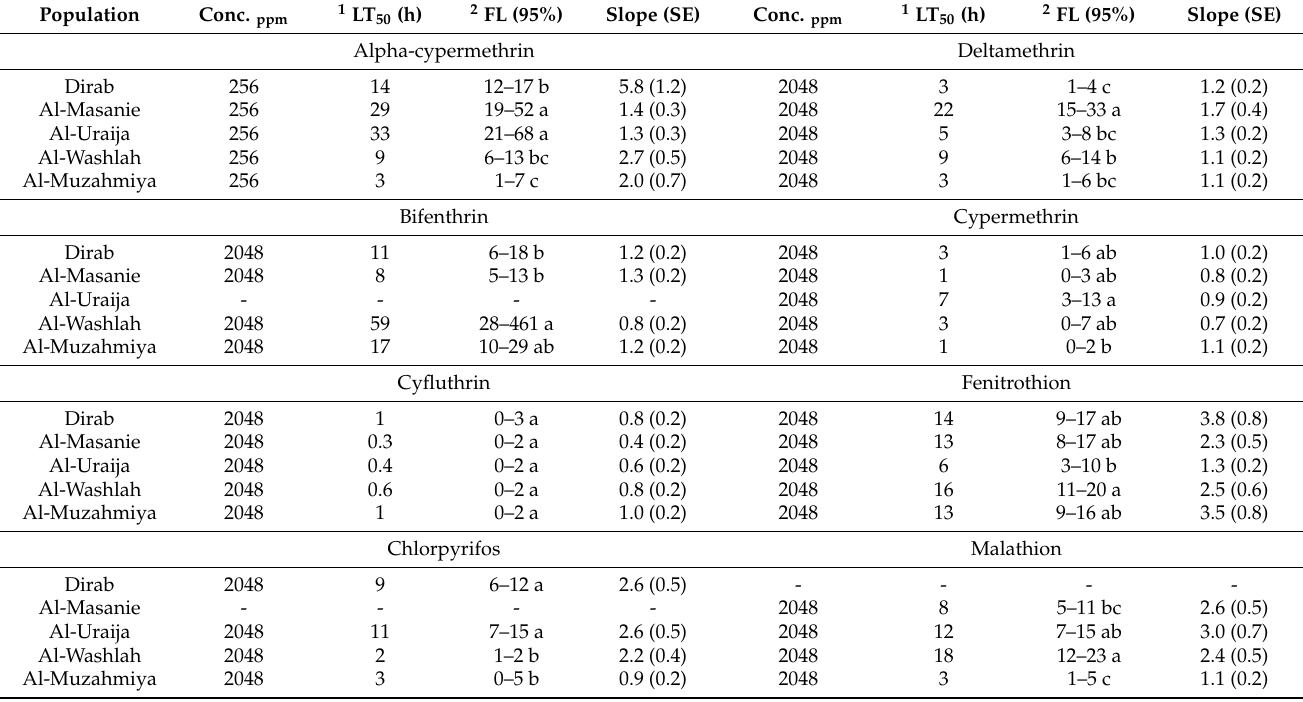
Table 5. Median lethal time (LT 50 ) of pyrethroids and organophosphates in male house flies. Population